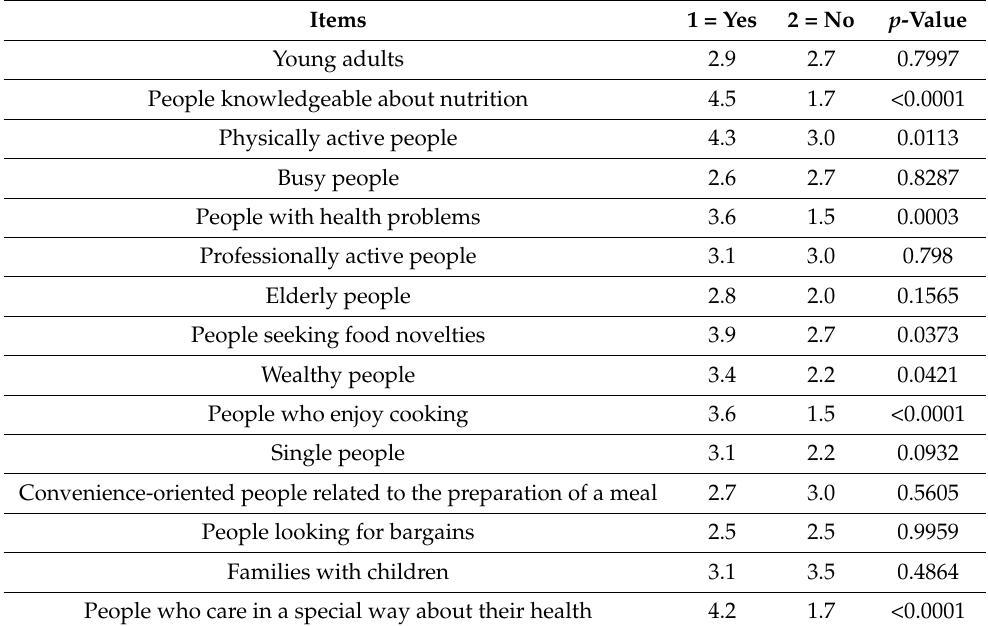
Characteristics/perceptions of consumers aware of the consequences of high sugar